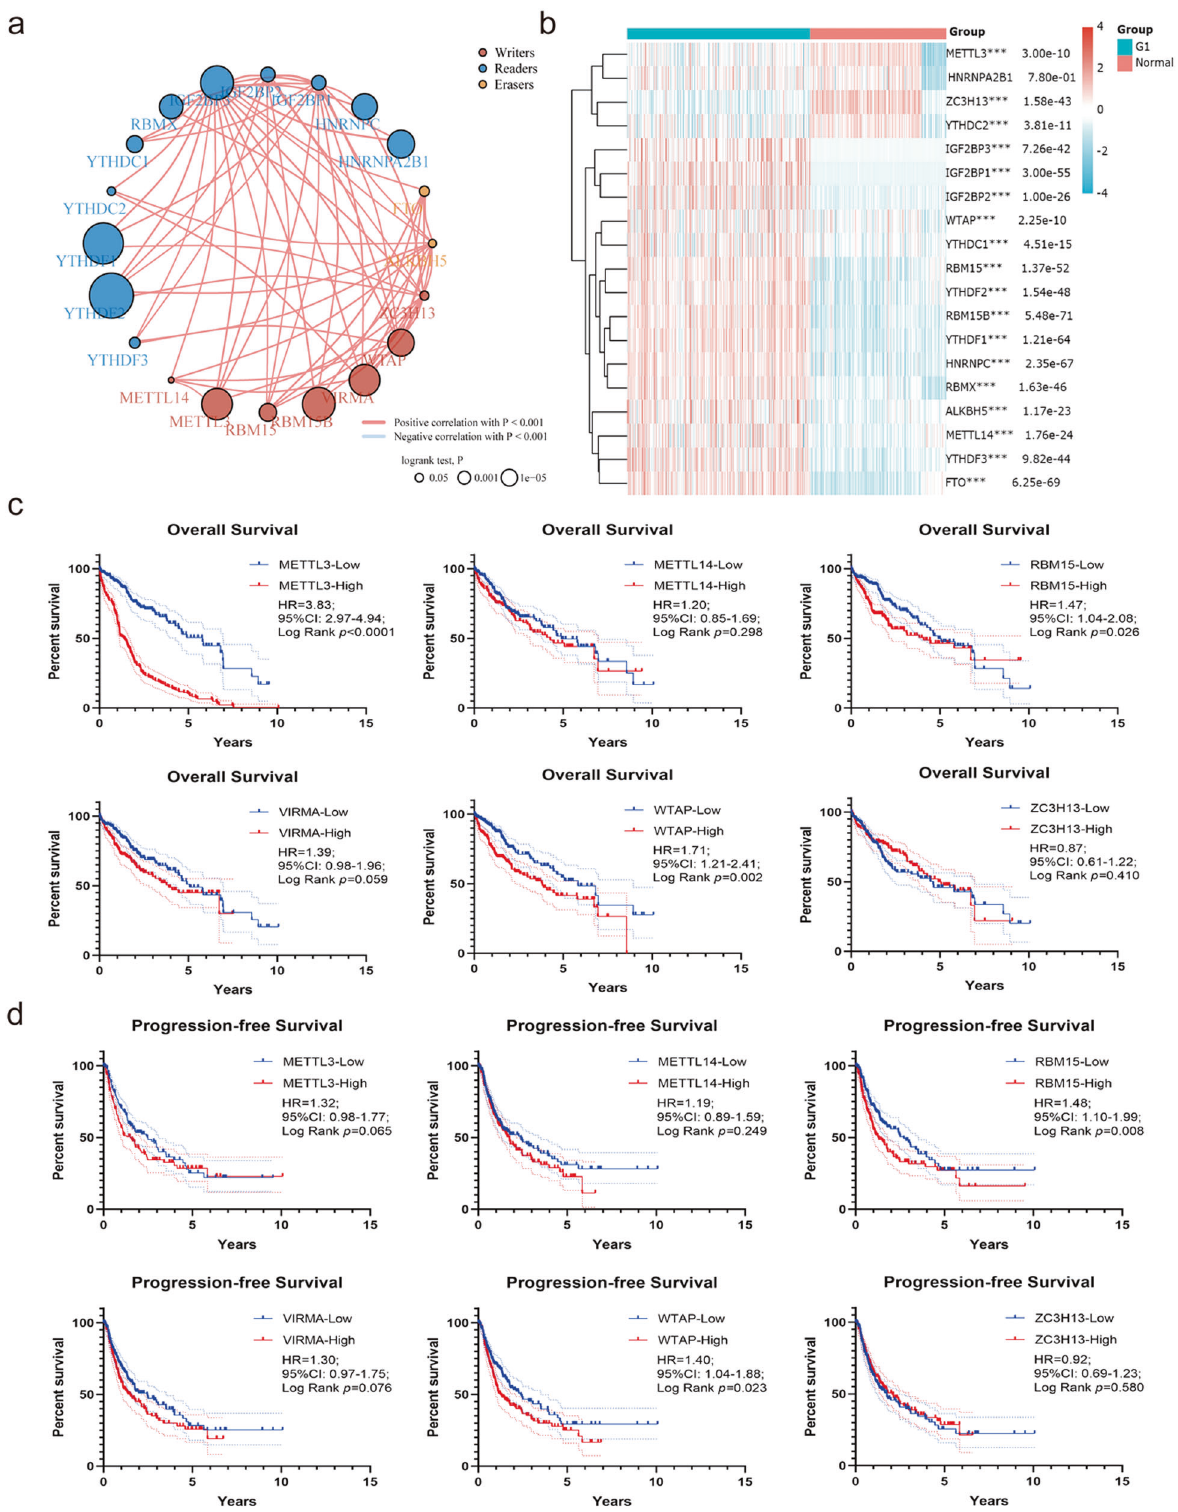
Fig. 1 Bioinformatics analyses of m6A modi fi cation-related genes in HCC. a Inter-relation between m6A “ writers, ” “ readers, ” and “ erasers ” ; b heatmap of m6A modi fi cation-related genes based on TCGA and GTEx data ( a , b were drawn online by ACLBI, http://www.aclbi.com/static/ index.html#/); c Kaplan – Meier analyses of overall survival of TCGA data based on different “ writers ” expression; d Kaplan – Meier analyses of progression-free survival of TCGA data based on different “ writers ” expression.